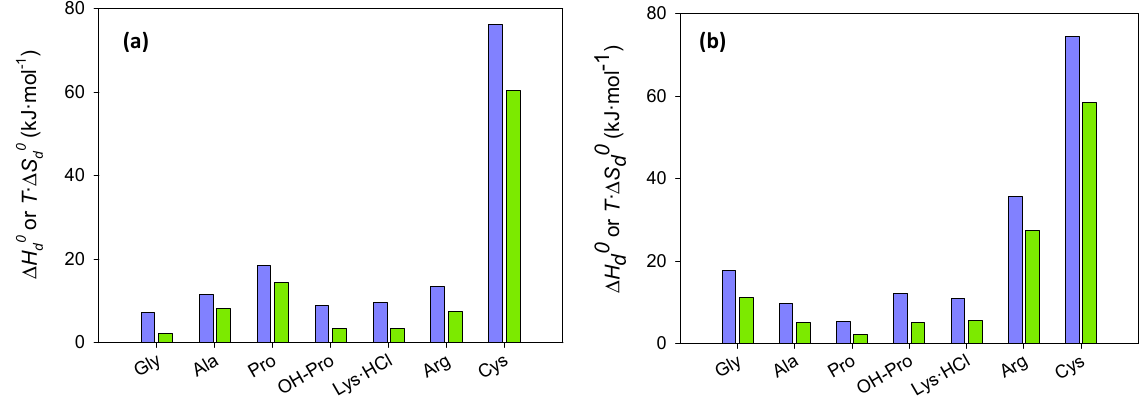
Figure 5. Enthalpic ( ∆ H o , blue/left bars) and entropic ( T hm · ∆ S o , green/right bars) contributions to the dissolution process in the eutectic solvent ( a ) and in its 50:50 (wt:wt) mixture with water ( b ).